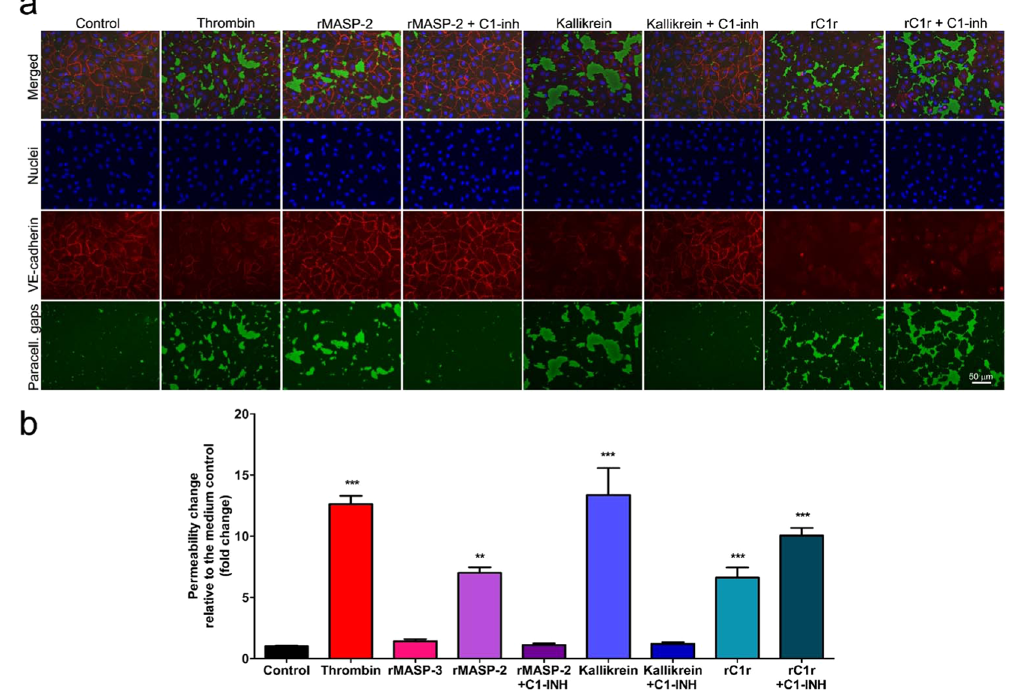
Figure 8. Effects of plasma serine proteases on VE-cadherin adhesion junctions and the permeability of HUVEC monolayers. ( a ) Permeability tests were carried out using a modified version of the XPerT technique. Briefly, confluent layers of HUVECs were seeded onto biotinylated gelatin-precoated 96-well microplates and cultured for 2 days. Cells were treated with thrombin (300 nM), rMASP-3 (1 μ M), rMASP-2 (2 μ M), rMASP-2/ C1-INH complex (2 μ M/ 6 μ M), kallikrein (2 μ M), kallikrein/C1-INH complex (2 μ M/ 6 μ M), rC1r (1 μ M), rC1r/C1-INH complex (1 μ M/ 3 μ M), or culture medium alone for 20 min. Streptavidin-Alexa488 was added to each well for 2 min and cells were fixed with 2% paraformaldehyde-PBS. VE-cadherin adhesion molecules were stained with anti-VE-cadherin antibody followed by an Alexa 568-conjugated seconder antibody. Cell nuclei were stained using Hoechst 33258. ( b ) The total area of the streptavidin-Alexa 488 stained paracellular gaps was determined on each image using the CellP software. Fold-change data are the mean ( + SEM) of three independent experiments calculated after normalization to the medium control. ** p < 0,001; *** p < 0,0001, relative to the control (One-way ANOVA with Tukey